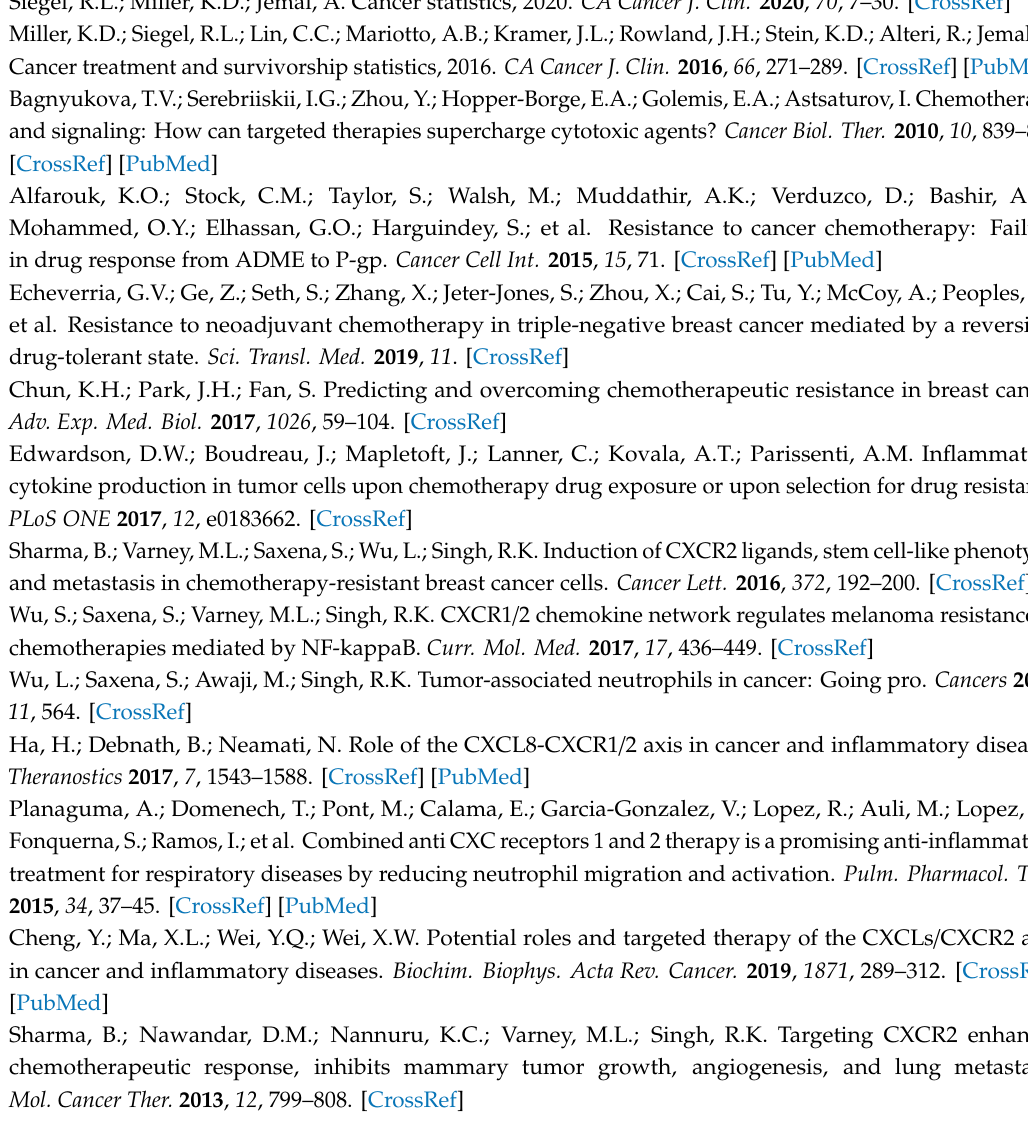
Figure S1: the whole blot (uncropped blots)